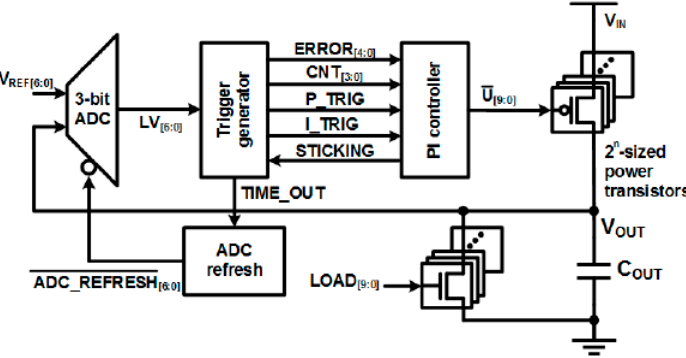
Figure 28. Event-Driven Explicit Time-Coding DLDO [55].